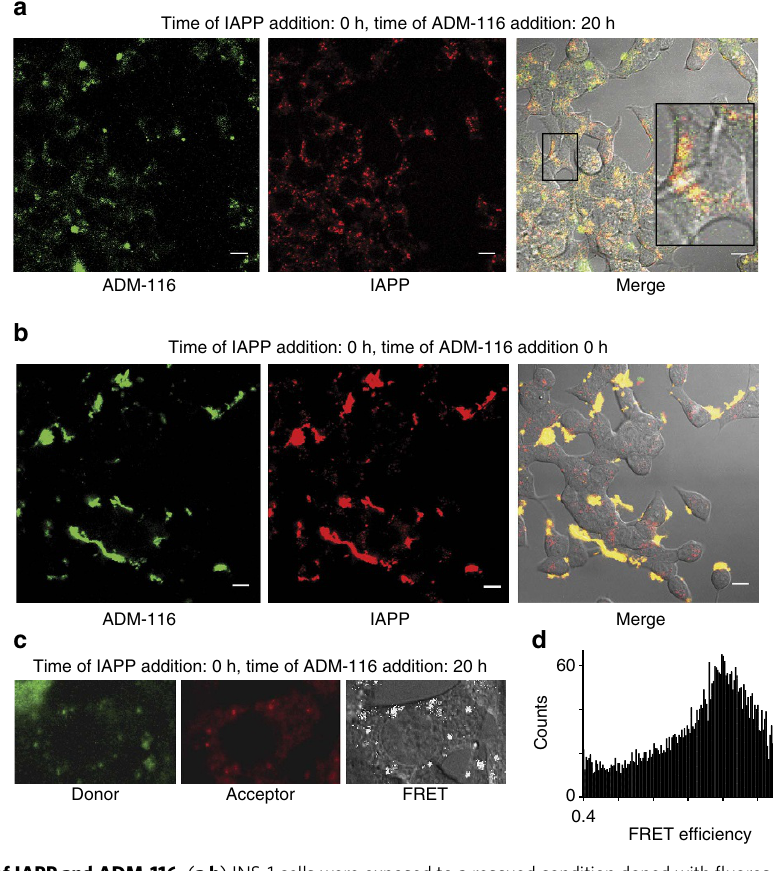
Figure 7 | Co-localization of IAPP and ADM-116. ( a , b ) INS-1 cells were exposed to a rescued condition doped with fluorescent variants of protein and ligand (13 m M IAPP, 15 m M ADM-116, 100nM IAPP A594 and 200nM ADM-116 F ). In a , small molecule and IAPP are co-introduced to the culture media. In b , the ligand is added 20h after protein. Scale bars, 10 m m. ( c ) as in b , but without the unlabelled components and initial incubation with IAPP was performed for 18h. Confocal fluorescence images were collected at the acceptor’s emission wavelength using donor (left) or acceptor excitation light (middle). FRET was computed from these channels and is shown as white dots on a DIC image of a representative cell. Only areas showing a FRETefficiency of 4 0.4 are shown as values below this are indistinguishable from background. Background FRET was determined using parallel experiments that included a further 13 m M of unlabelled IAPP (Supplementary Fig. 11). ( d ) FRET histogram depicting the total counts at the indicated FRETefficiencies across B 50 regions of interest. The data shown have been repeated three times. The FRETefficiency calculated is an average of fifty cells imaged, performed across three independent biological